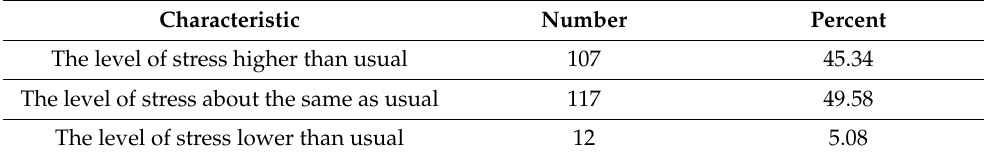
Table 3. Residents’ level of stress during the pandemic.